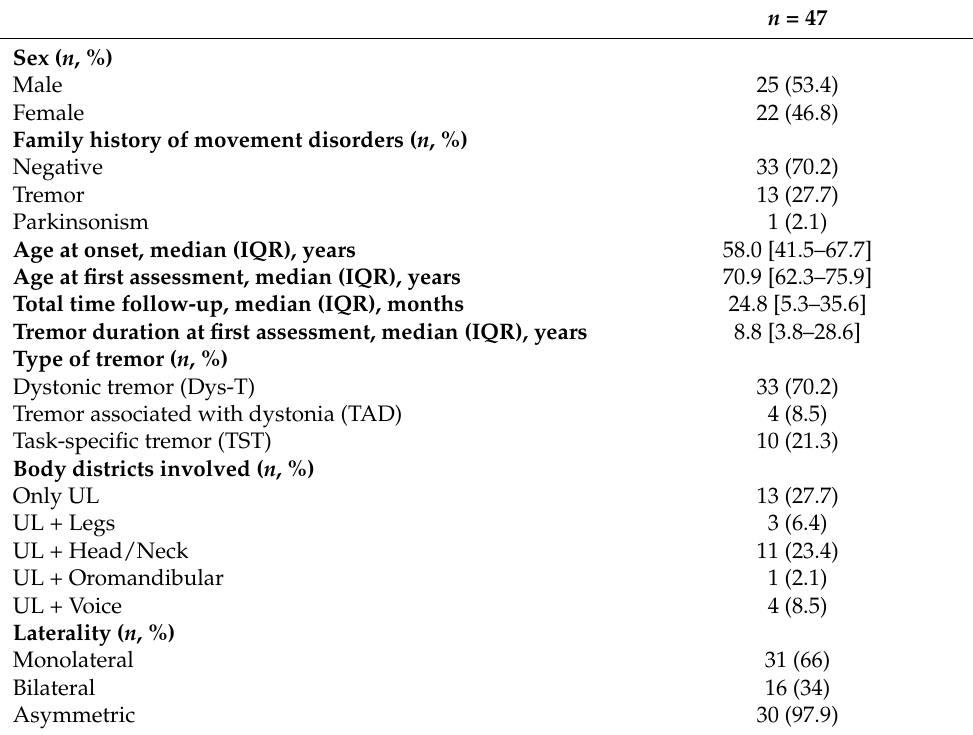
Table 1. Demographic and clinical data of subjects with dystonic tremor, tremor associated with dystonia, and task-specific